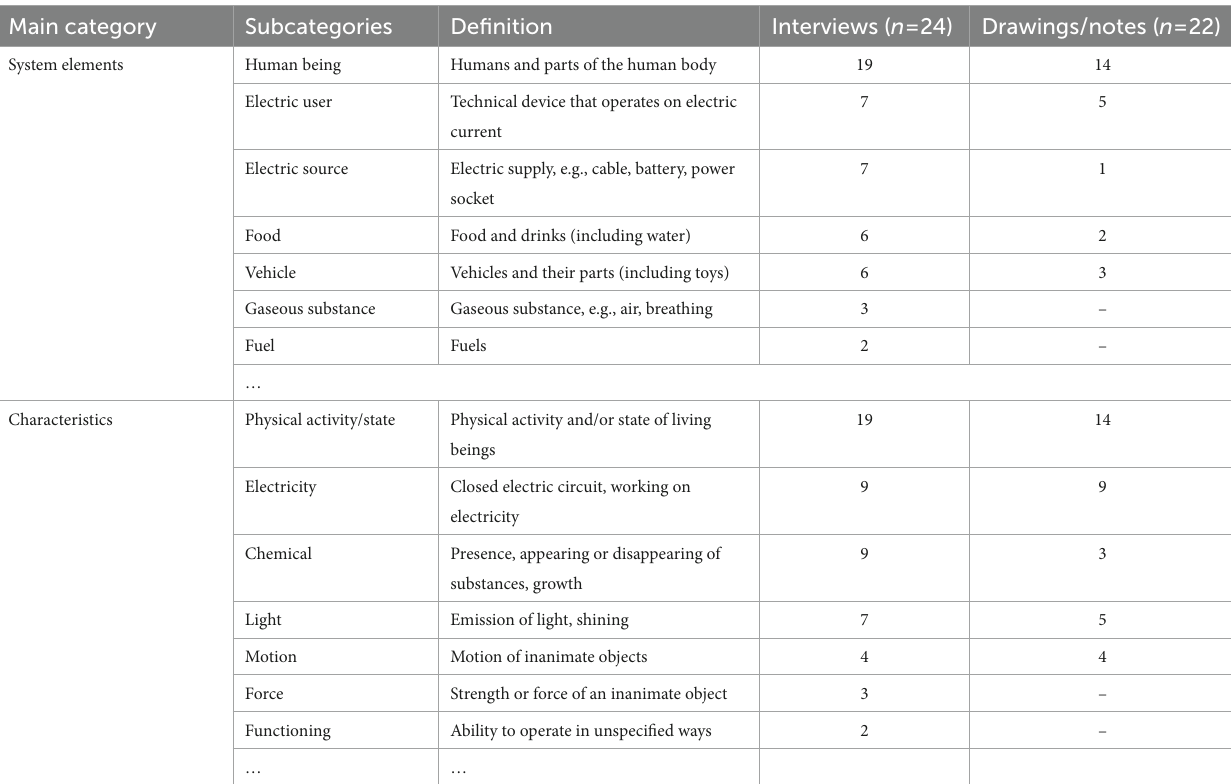
TABLE 3 Coding systems for the main categories system elements and characteristics (excerpts, cf. Detken and Brückmann, 2021) and frequencies of documents (interviews and drawings/notes) with assigned